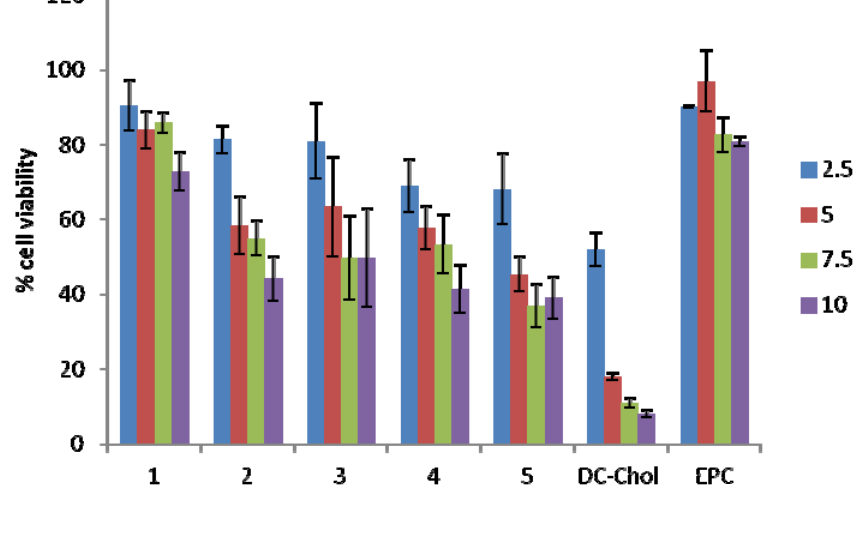
Figure 5. Cytotoxicity of carotenoid lipoplex formulations, 1 – 5 , and control lipids DC-Chol and EPC, 48 h after transfection with various N/P (+/ − ) molar charge ratios. The percentage of viable cells was calculated as the absorbance ratio of treated to untreated cells. Data for (+/ − ) molar charge ratios 2.5–10 are the average of three experiments (n = 9); Data are expressed as mean ±